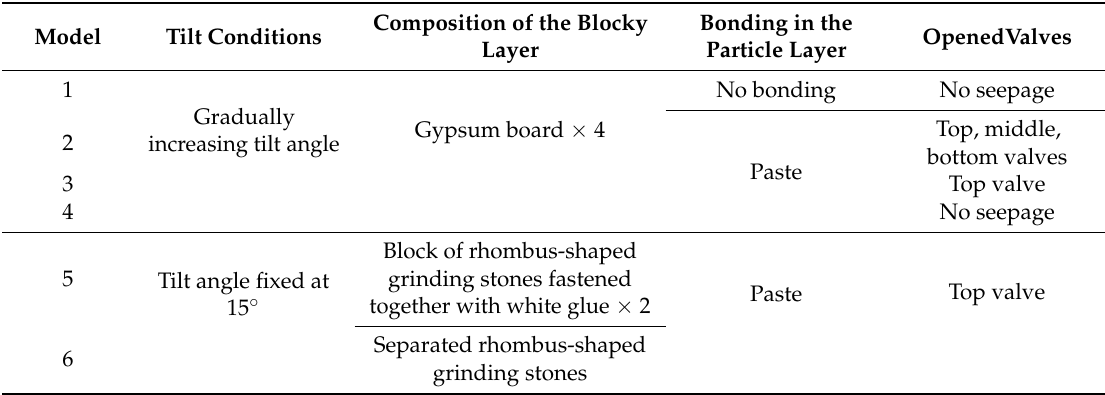
Figure 5. Configuration of the specimen and cameras. Table 1. Conditions of the physical test.